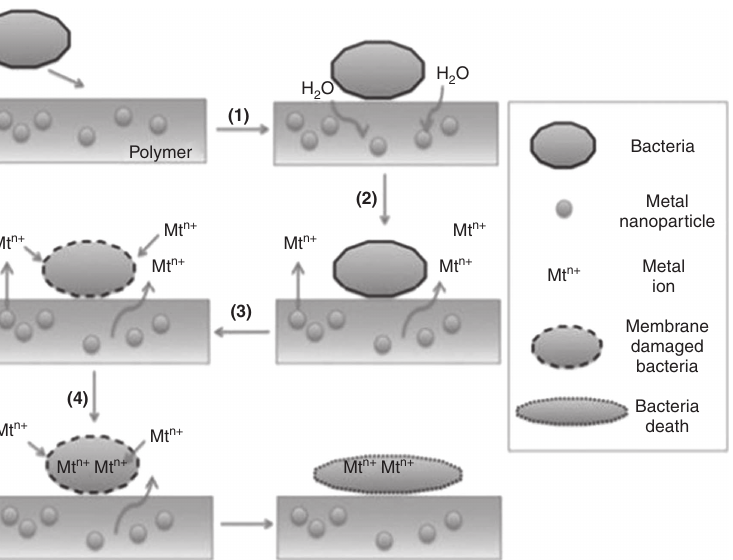
Figure 19: The antimicrobial mechanism of polymer/metal nanocomposites. Adapted from Ref. [49], Copyright (2015), distributed under the terms of the Creative Commons Attribution